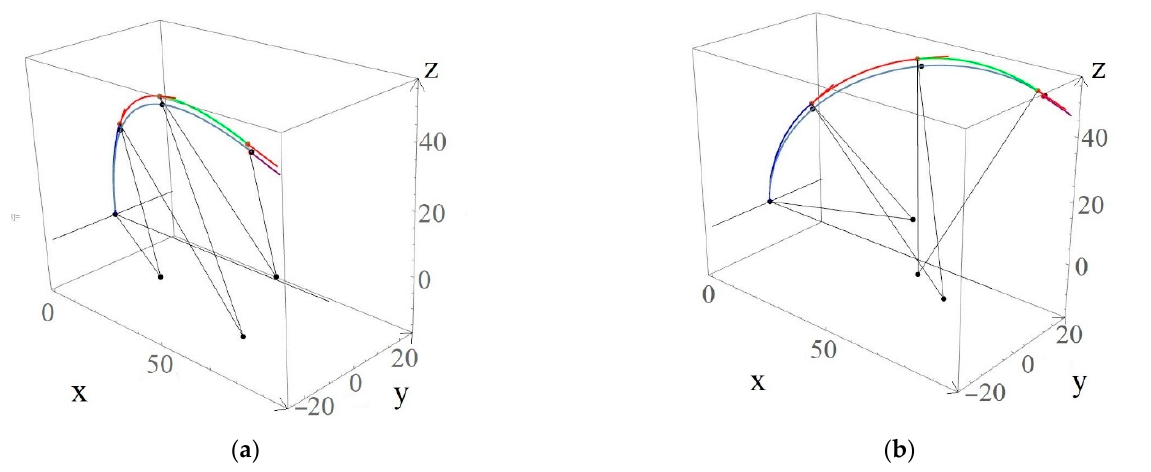
Figure 18. Bent spine views with different endpoint direction unit vector (cid:1815)(cid:3549) (cid:2928) (purple vector) and (cid:1833) goal point (redpoint) coordinates’ representation. The light blue curve is an estimated robot spine curve, and the calculated robot segment arc curves are in blue, red, and green: ( a ) robot spine view when (cid:1833) = (87.3016, −25,49.8118) and (cid:1815)(cid:3549) (cid:2928) = (0.9397,0, −0.342) ; ( b ) robot spine view when (cid:1833) = (87.3016,25,49.8118) and (cid:1815)(cid:3549) (cid:2928) = (0.9397,0, −0.342) .